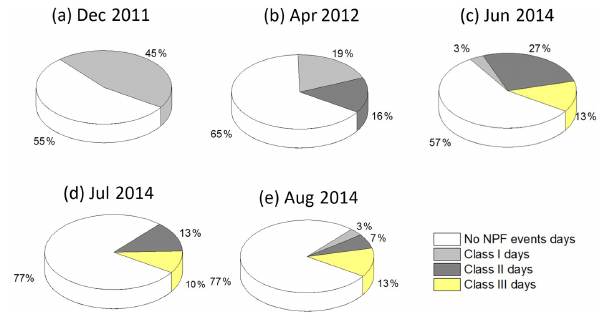
Figure 2. Occurrence frequencies of difference growth patterns of NPF events in observational